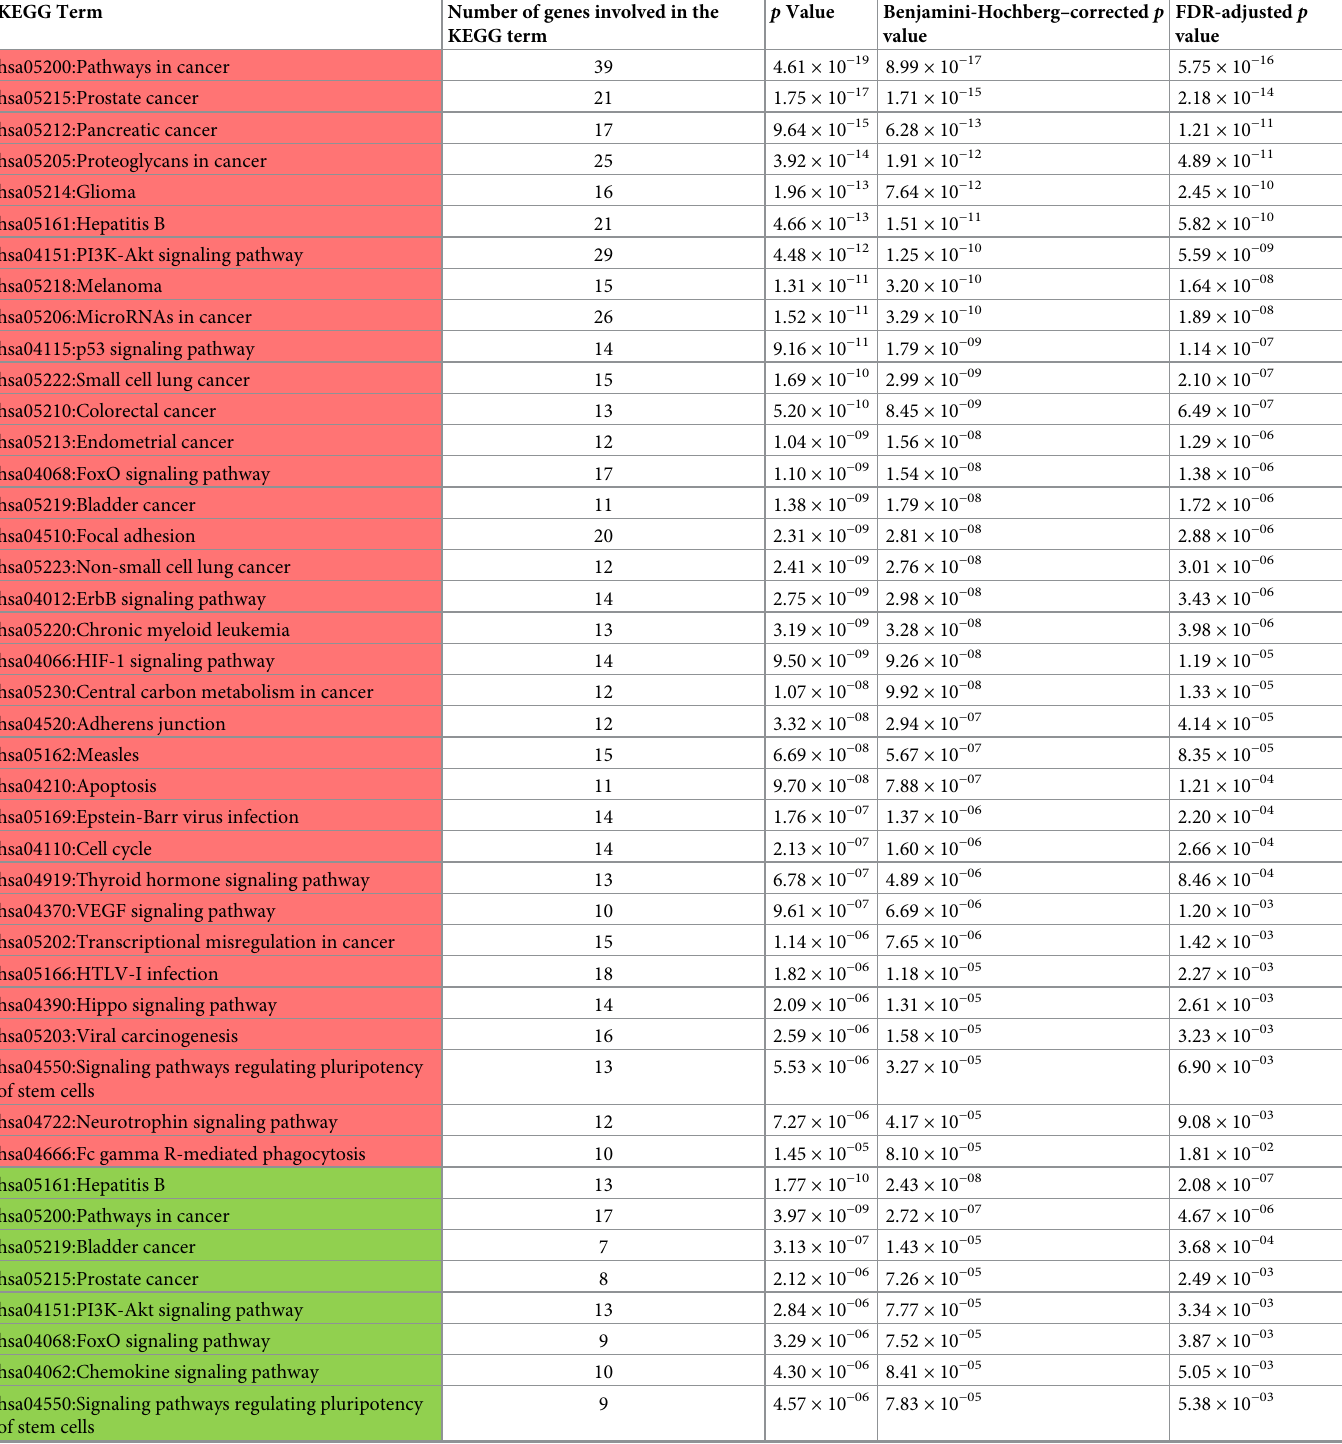
Table 4. Functional annotation of miRNA targets of up- and downregulated miRNAs associated with spontaneous term birth. Targets associated with either up- or downregulated miRNAs of Table 2 analyzed separately by DAVID analysis [43] according to KEGG pathways. Results for targets of up- and downregulated miRNAs are shown in red and green, respectively. KEGG terms with false discovery rate (FDR)–adjusted p values of < 0.05 are